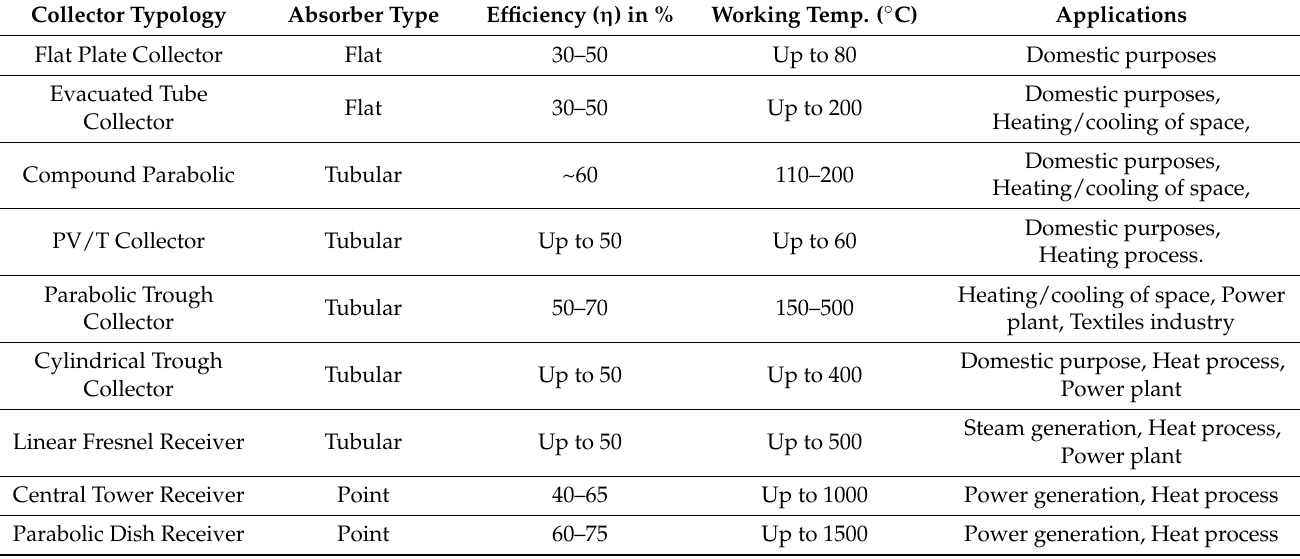
Table 1. Detailed summery of solar thermal collectors [11,12].